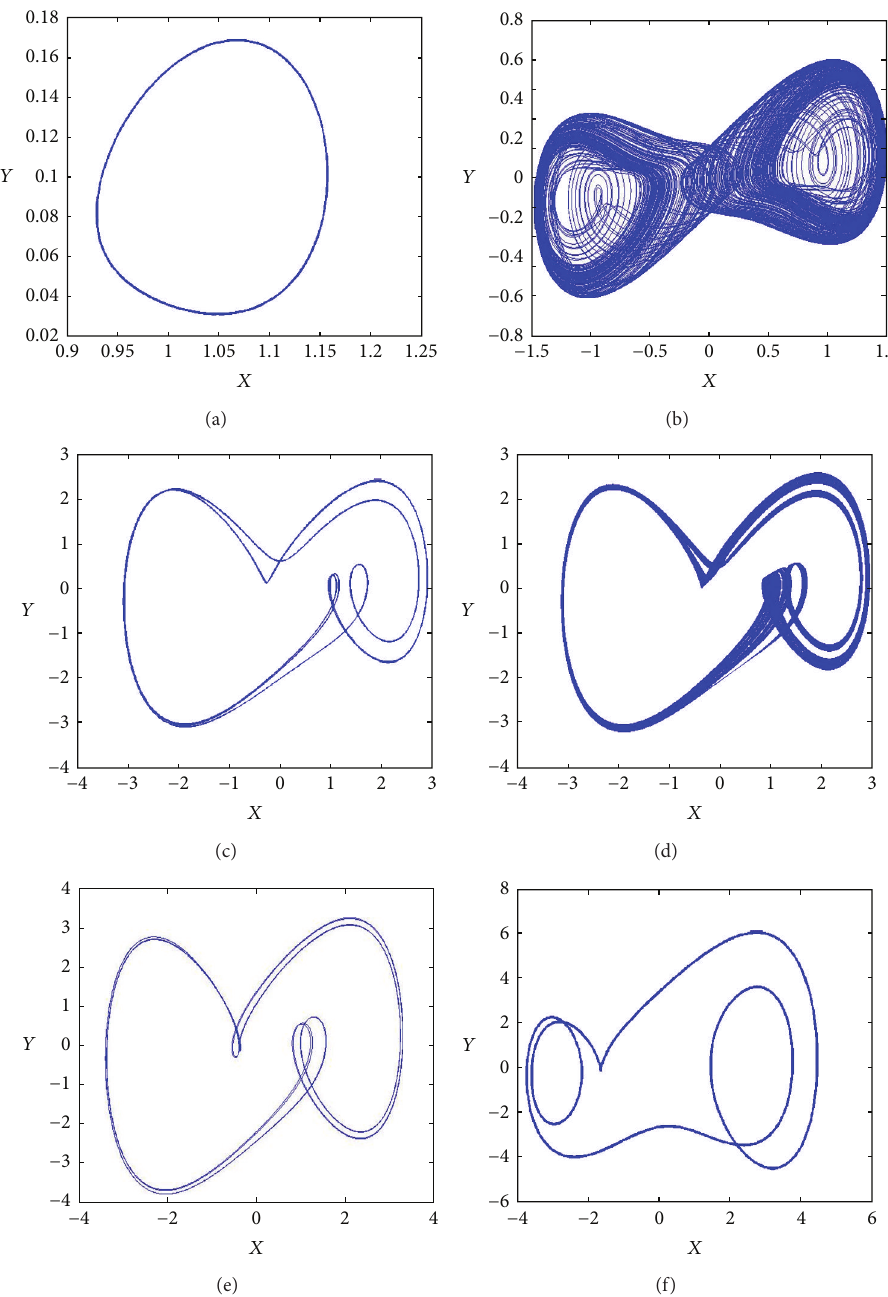
Figure 1: Phase portraits of coronary artery system at 𝐸 = (a)0.1, (b) 0.3, (c) 4.3, (d) 4.5, (e) 5.9, and (f)